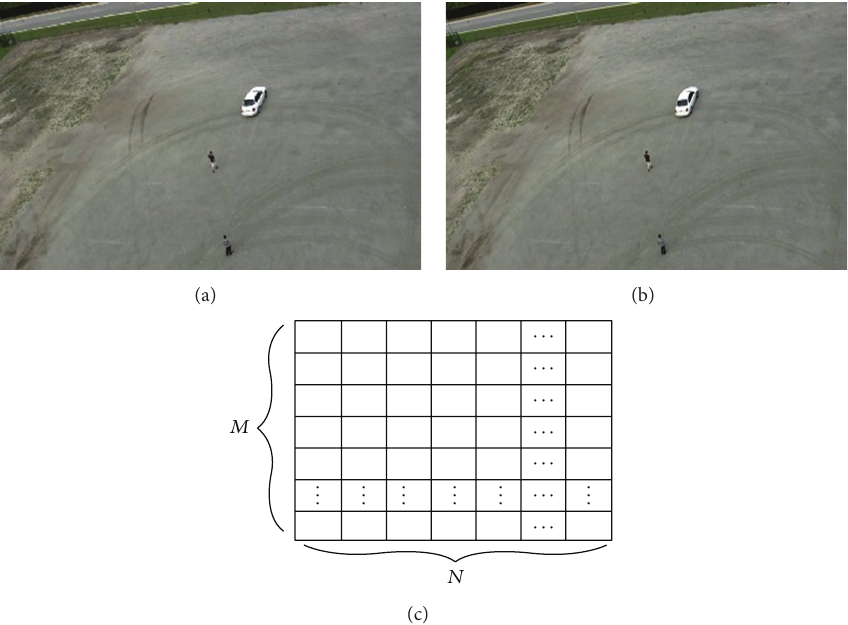
Figure 6: (a) 𝐼 𝐵 (𝑚, 𝑛,𝑡) at frame 101. (b) 𝐼 𝐵 (𝑚,𝑛, 𝑡) at frame 102. (c) 𝐼 𝐵 (𝑚,𝑛, 𝑡)